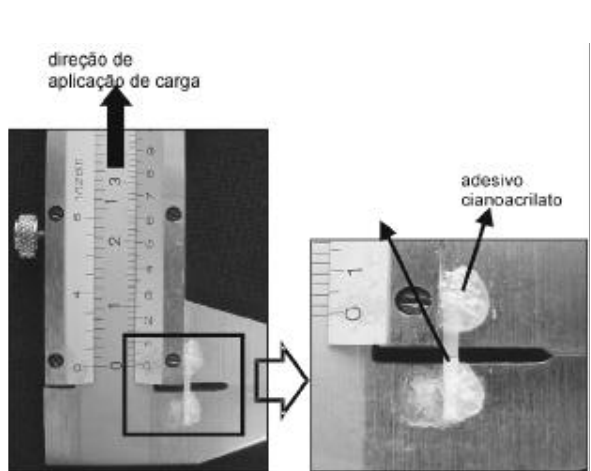
FIGURA 4 - Corpo-de-prova fixado nas hastes do paquímetro